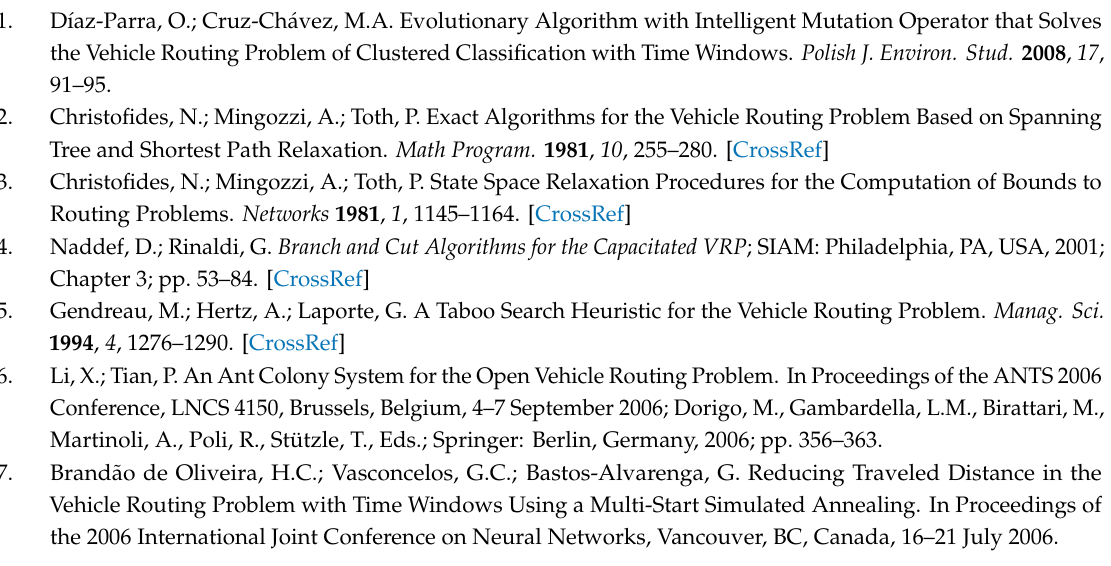
Figure 13. p -values graph of the compared methods.